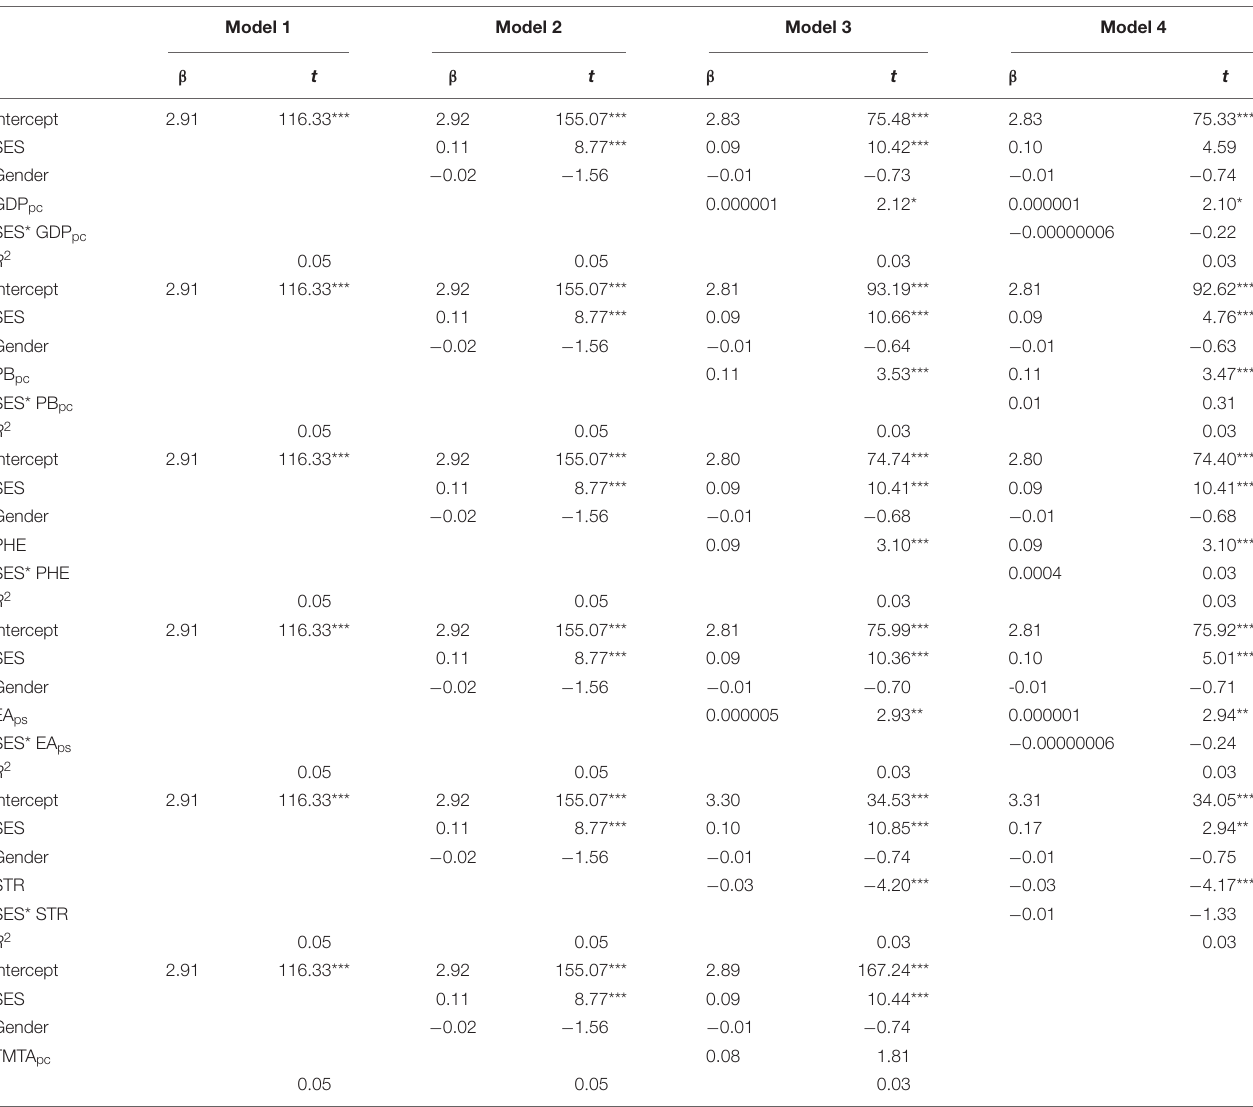
TABLE 4 | The effect of gender, SES and provincial factors on cognition